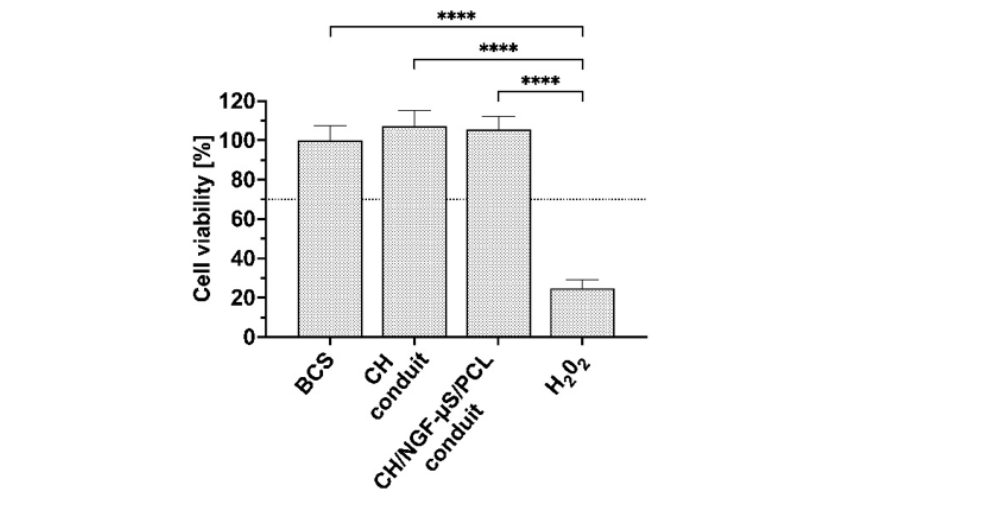
Figure 9. Proliferation of mHippoE-18 cells in response to CH and CH/NGF-µS/PCL conduits in comparison to proliferation rate in the presence of the reference material (BCS). Data are shown as